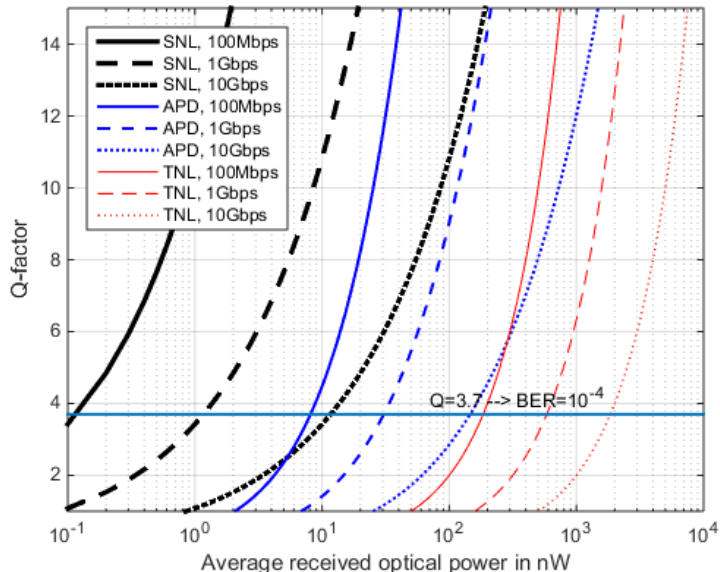
Figure 8. RFE sensitivity for the three RFE cases where M = 25. The RFE here has a constant TIA noise density but an adoptive Rx lowpass.